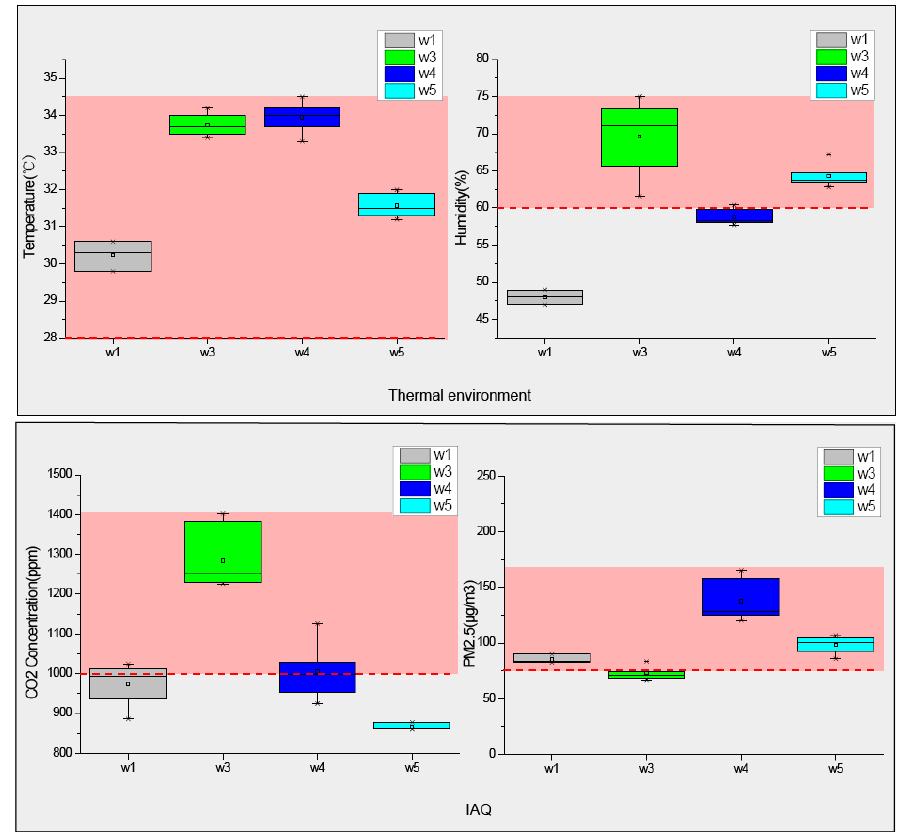
Figure 10. Box diagram of the physical test results from the platform layer.